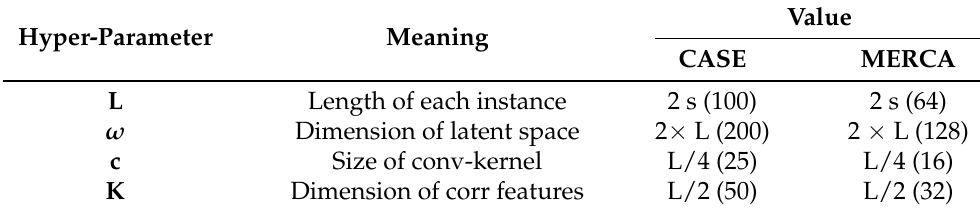
Table 2. The value of hyper-parameters in CorrNet.